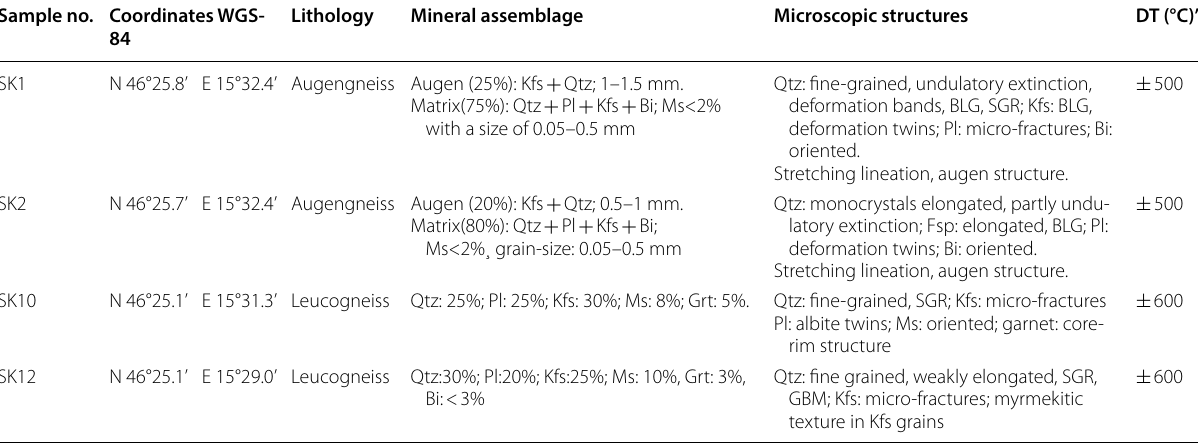
Qtz: quartz; Fsp, feldspar; Pl, plagioclase; Afs, alkali feldspar; Bi, biotite; Ms, muscovite; BLG, bulging; SGR, subgrain rotation; GBM (grain boundary migration); DT, deformation temperature, which is estimated based on Stipp et al. (2002a, 2002b, 2010)